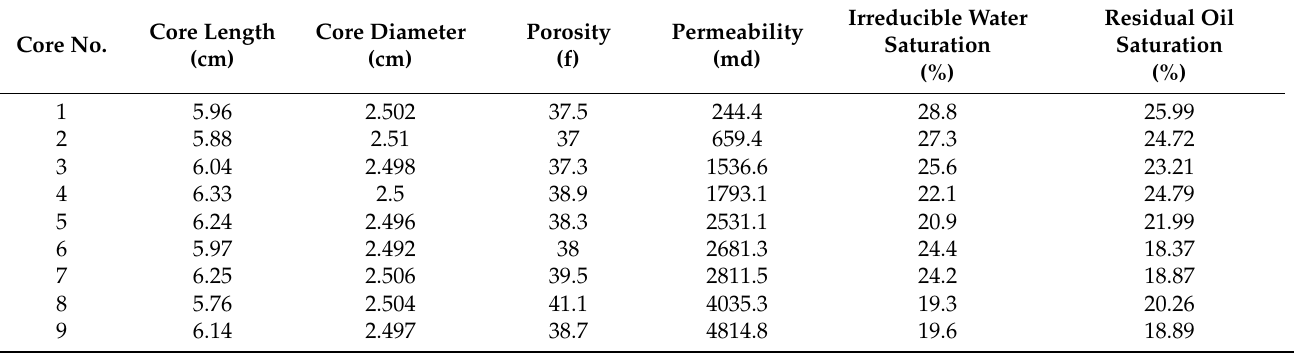
Table 1. Summary of the experiment